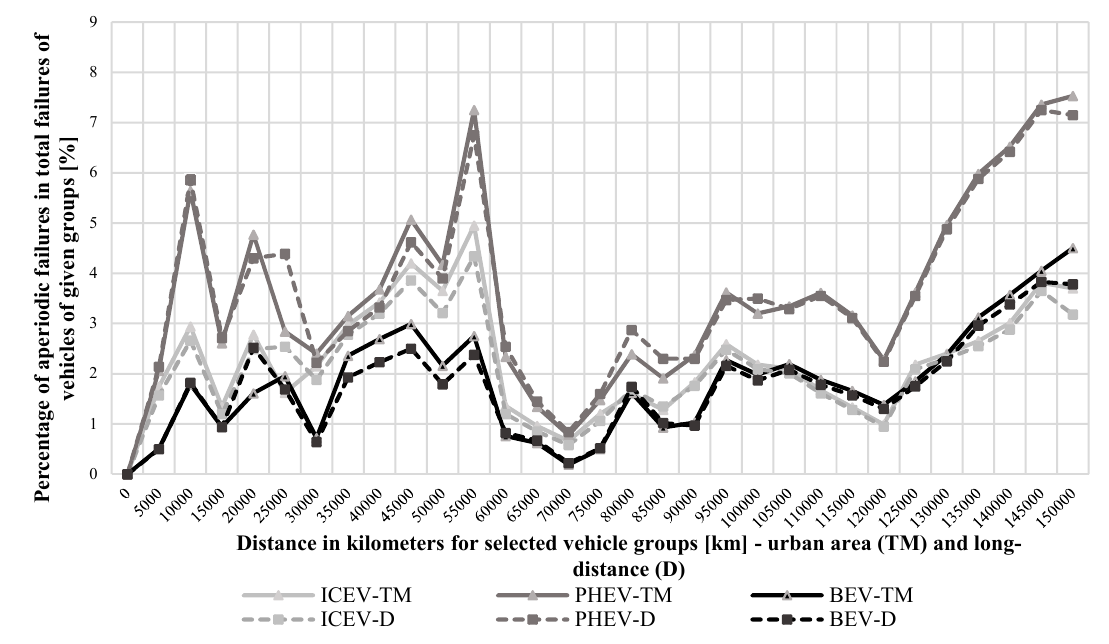
Figure 11. Distribution of aperiodic failures for a large limousine with ICEV, PHEV, and BEV propulsion for urban and long-distance speed profiles over a distance of 150,000 km.